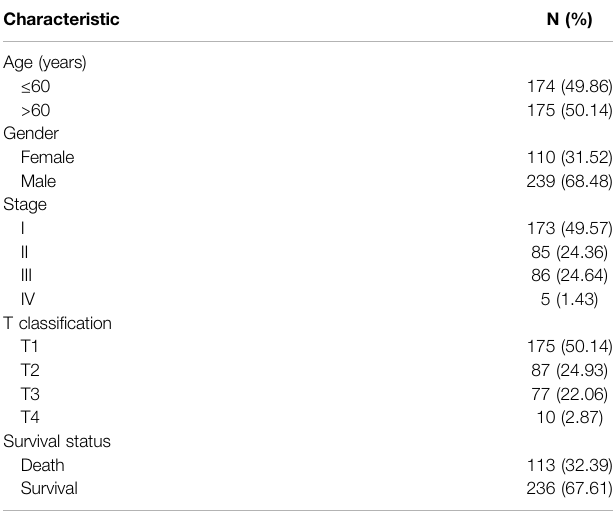
TABLE 1 | Clinical characteristics of the 349 LIHC patients downloaded from the TCGA database. Characteristic